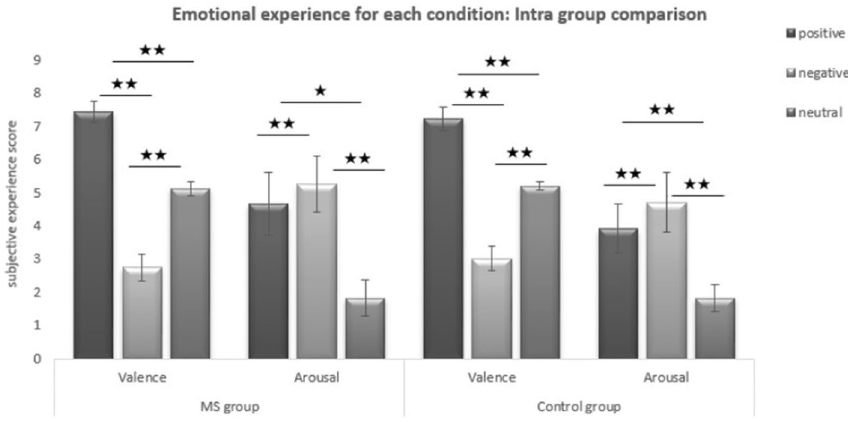
Figure 2. Intra-group comparisons of emotional experience in MS scoring for each condition. *Significant difference at p < 0.05; **Significant difference at p < 0.01.